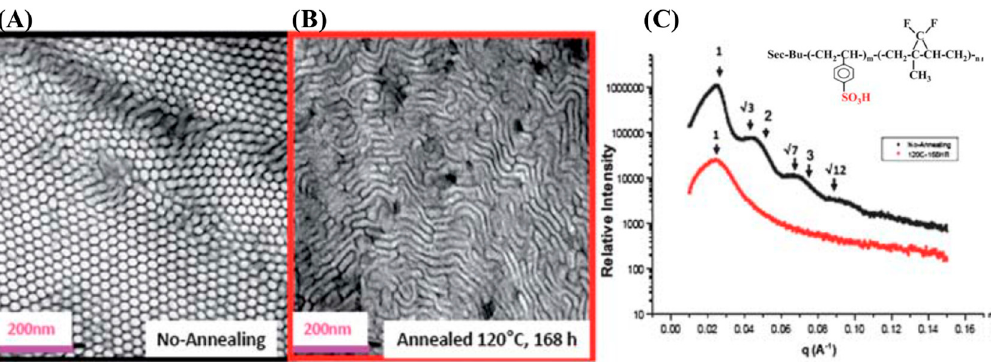
Figure 8. TEM and small-angle X-ray scattering (SAXS) images of s PS- b - f PI. ( A ) ordered hexagonal structures without annealing; ( B ) less ordered structures of sample annealed at 120 °C; ( C ) SAXS of the corresponding samples in ( A , B ). Reprinted from Reference [72]. (Copyright (2010) Royal Society of Chemistry).